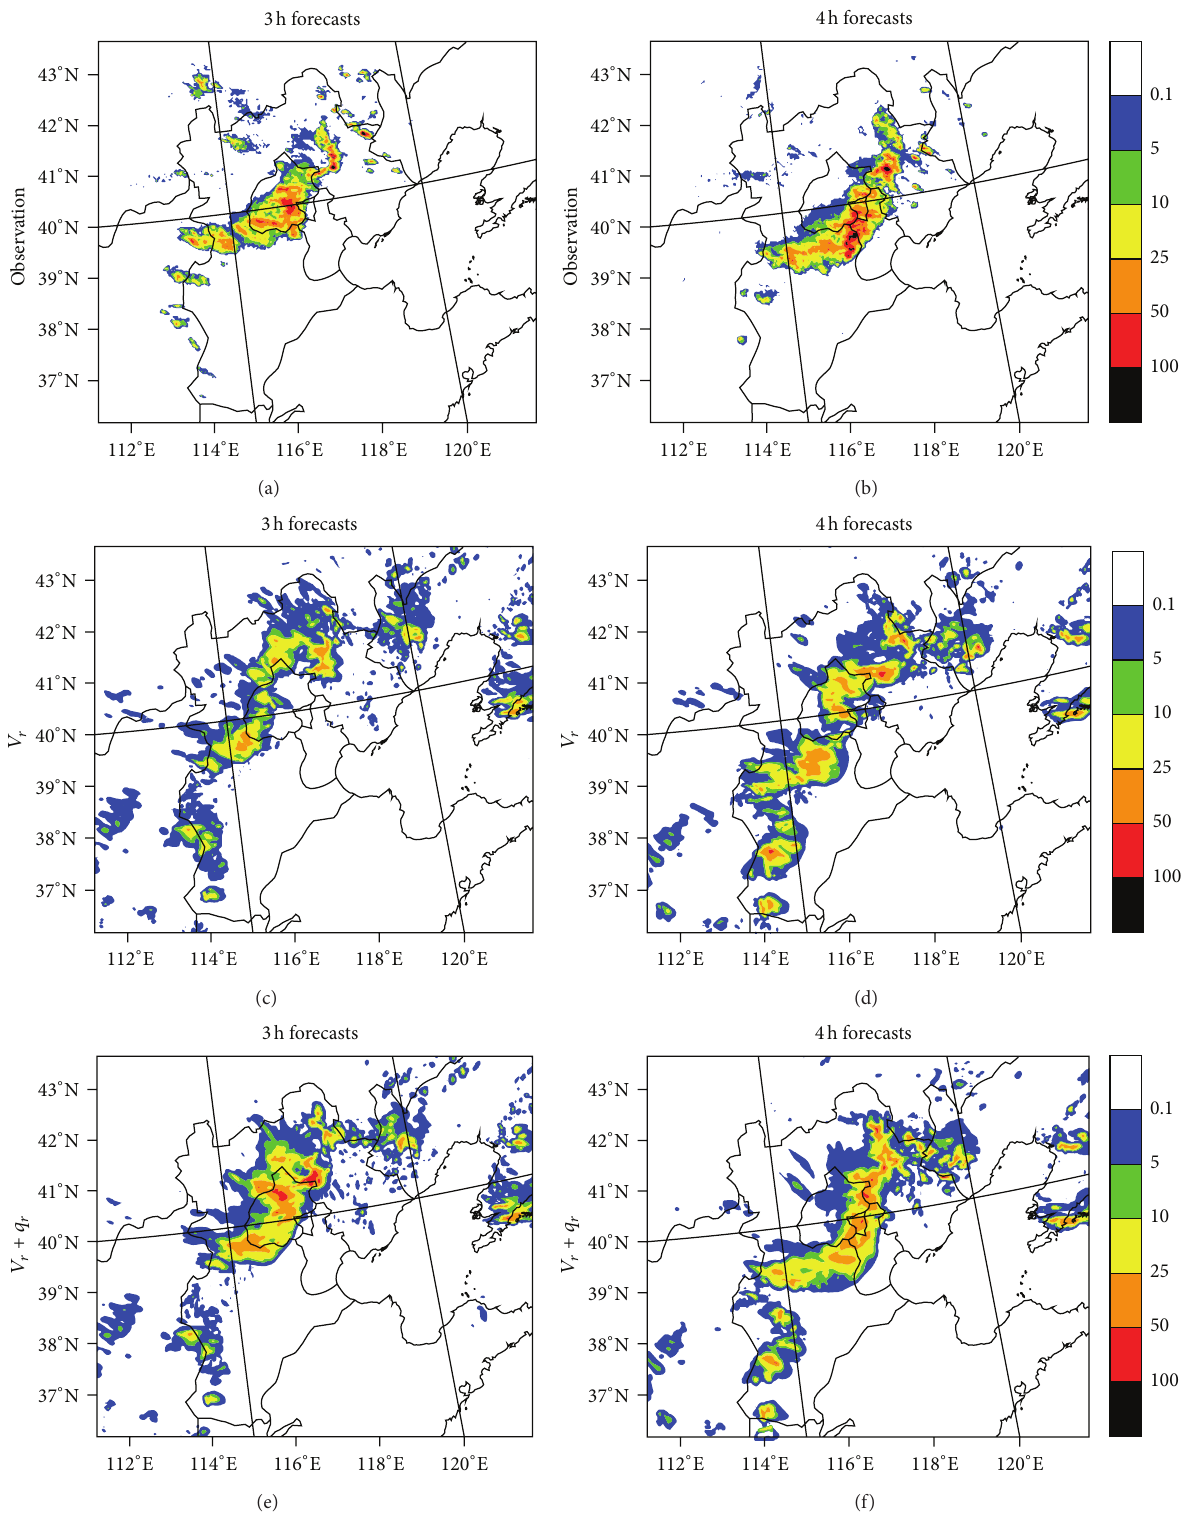
Figure 3: Hourly accumulated precipitation (unit: mm) for the convective case that occurred on July 23, 2009, in Beijing, China. The 3-hour (left column) and 4-hour (right column) forecasts are initialized at 0600 UTC by a 3 hourly cycled WRF 3D-Var. The radar QPE ((a) and (b)) is used to verify the experiments that assimilate radar radial velocity ((c) and (d)) only and that assimilate both radial velocity and rain water mixing ratio derived from reflectivity ((e) and (f)) (from